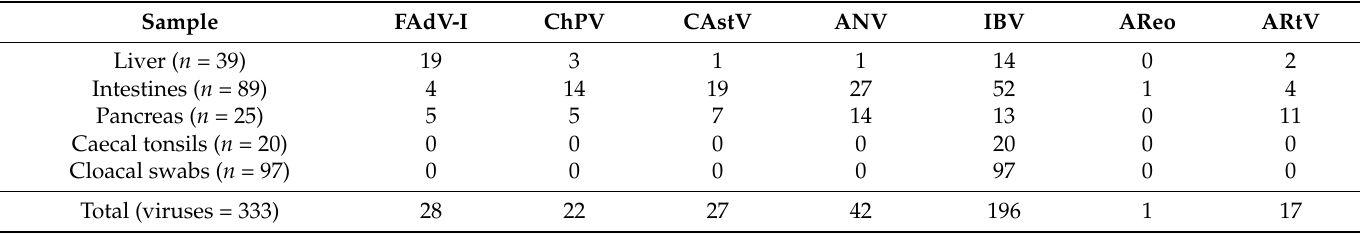
Table 7. Frequency of viruses found in different digestive